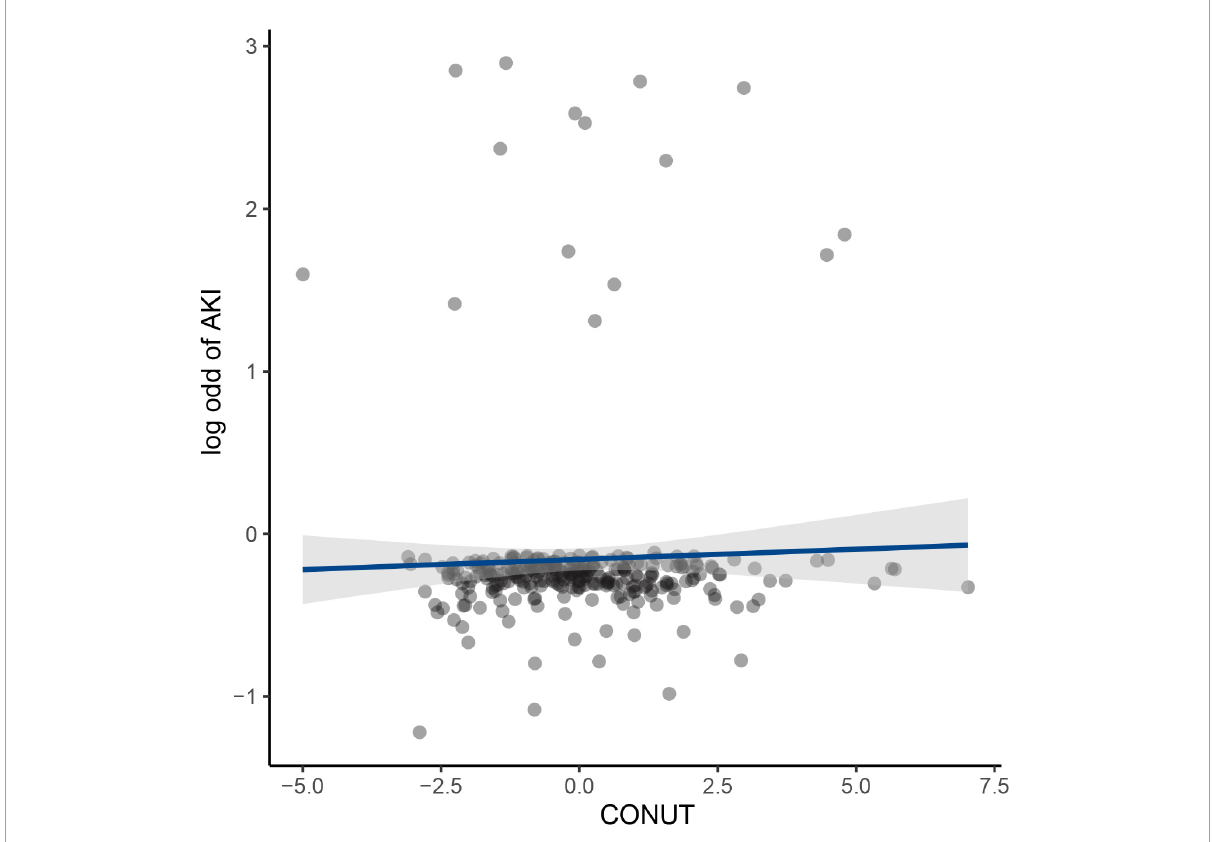
FIGURE3 Partial effect plot in full model for Controlling Nutritional Status